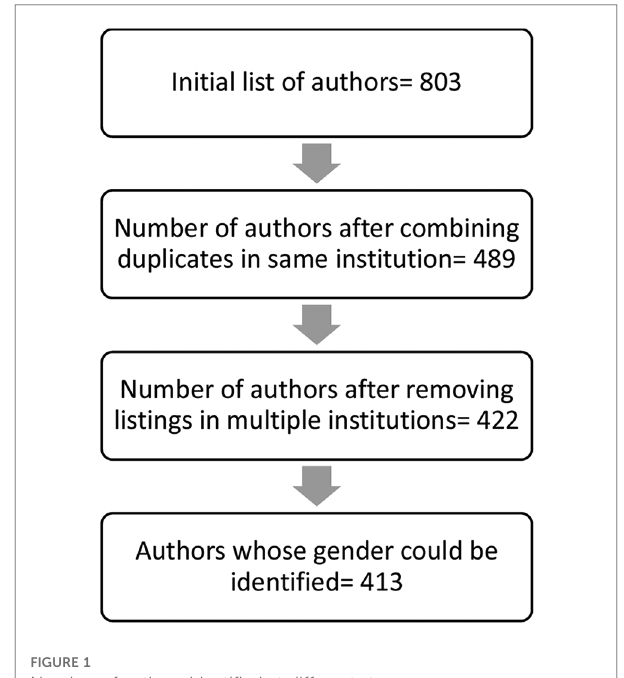
FIGURE 1 Number of authors identi fi ed at different